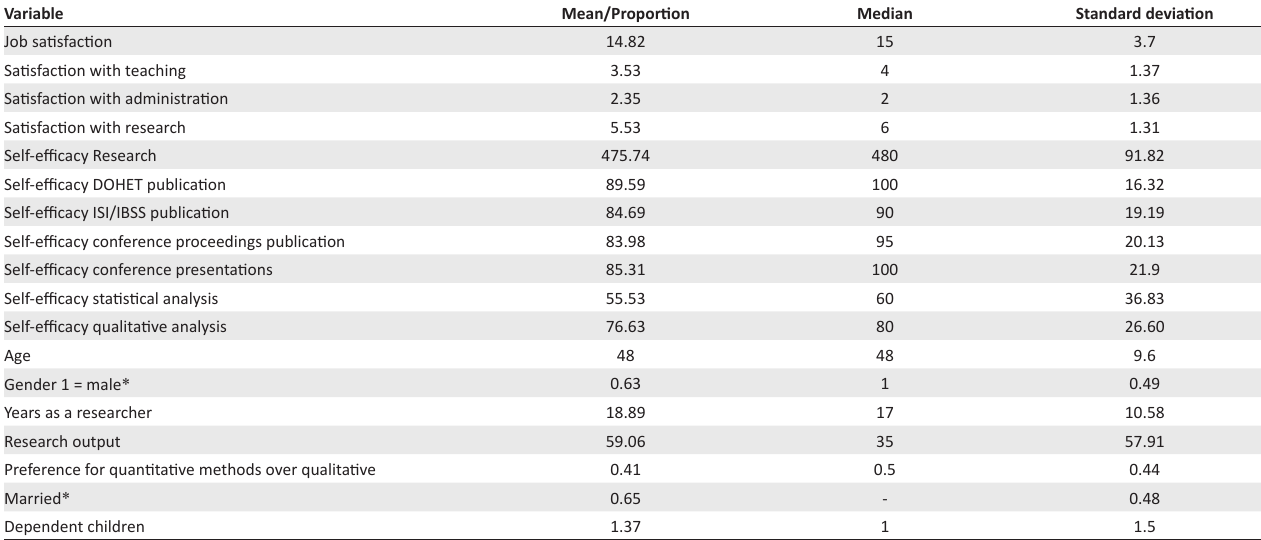
TABLE 3: Descriptive statistics: Professorial